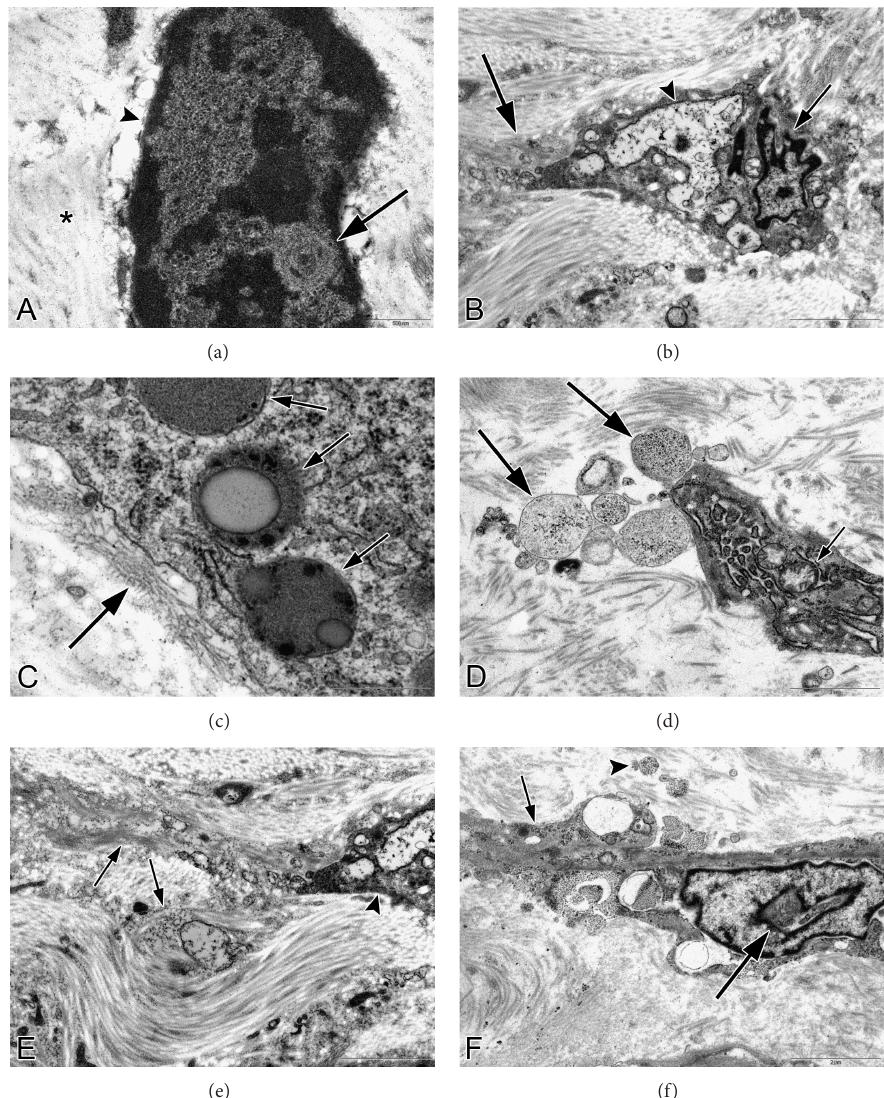
Figure 19: Ultrastructure of inanosis and reclamation. The nucleus in (a) is lying free within the stroma and shows a swollen, discontinuous nuclear envelope (arrowhead) that is being resorbed. The nucleus itself appears relatively intact except for the whorl in the lower right (arrow). Note the loosely expanded, watery stroma (asterisk) surrounding the nucleus. The nucleus of the shrunken cell in (b) displays a rippled or serrated border (short arrow) resembling the acanthanuclear alteration sometimes seen with the light microscope. The large vacuolar structure in the cytoplasm (arrowhead) could be dilated endoplasmic reticulum or possibly a phagolysosome and may correspond to the cytoplasmic vacuoles seen with the light microscope. The cytoplasmic tail at the left (long arrow) is degenerated and could be a precursor to autoamputation. In (c), myofilaments (long arrow) appear to lie outside of the cell membrane within a loosely expanded, watery stroma, suggesting that they have either leaked out or have been extruded. Three phagolysosomes (short arrows) are present in the cytoplasm of the cell. The cell in (d) shows budding of cytoplasmic debris (long arrows) from the elongate end of the cell. Some of the rounded particles could be autophagolysosomes with free ribosomes and degenerated cytoplasm. The cytoplasm of the cell consists almost entirely of dilated ER and swollen mitochondria (short arrow), with few remaining filaments. The tail of the cell in (e) exhibits complete degeneration of cytoplasm and organelles (arrows), with apparent loss of the cell membrane, while the remaining portion of the cell on the right (arrowhead) appears to be viable; the appearance suggests that cells might be capable of segmental autoamputation. The cell in (f) illustrates both the end stage of inanosis and the resorptive process of reclamation. The cytoplasmic contents are degenerated, granular, and vacuolated (short arrow), and the cell membrane has been breached in some areas, resulting in extrusion of degenerated cytoplasm into the adjacent watery stroma with disrupted collagenous matrix (arrowhead). The nuclear chromatin is condensed, and there is a degenerative structure in the middle (long arrow). Note that in each photo ((a)–(f)), the inanotic cells or cell particles are surrounded by loosely expanded, watery stroma, which is believed to correspond to the clear spaces sometimes seen around inanotic cells with light microscopy and thought to represent resorption pits associated with the reclamation process. Original magnification of (a): 26,500x, (b): 9,900x, (c): 43,000x, (d): 9,900x, (e): 9,900x, and (f):